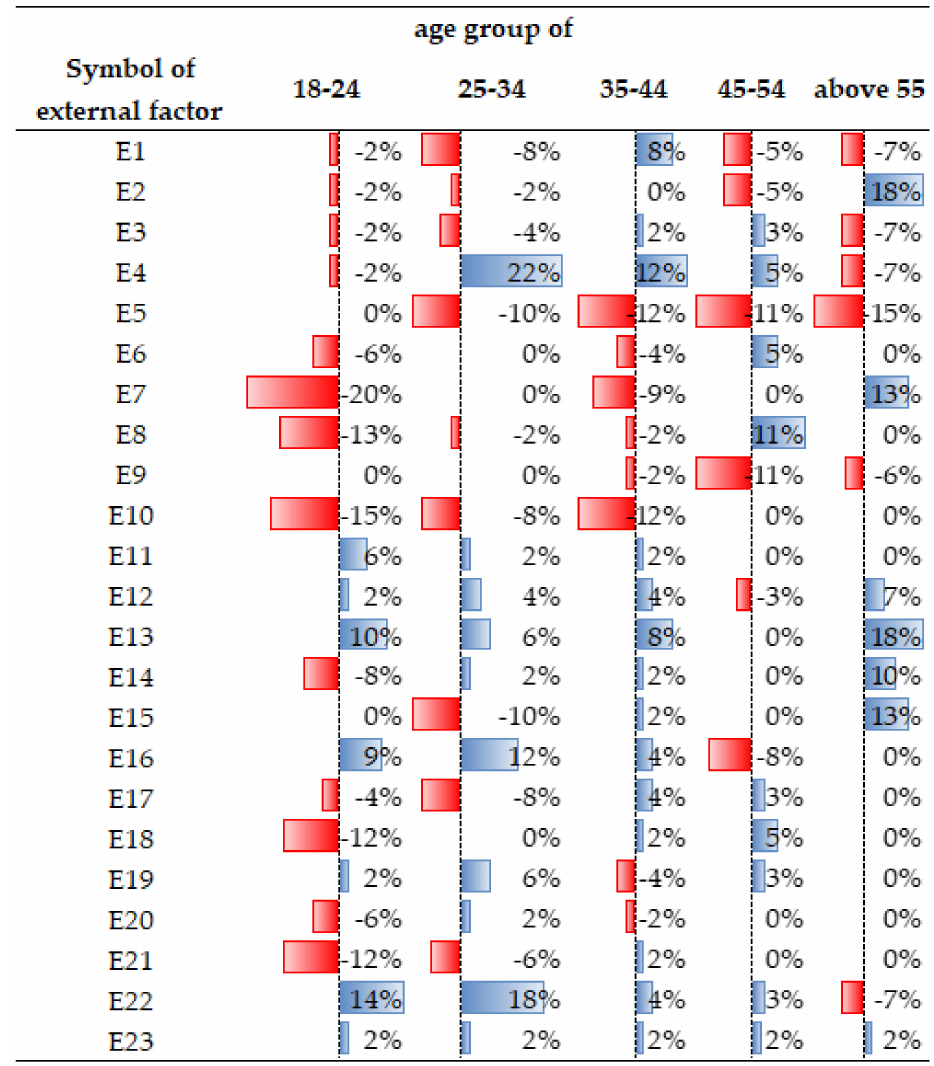
Figure 6. Differences in the perception of external factors, broken down by age groups. Source: own study.